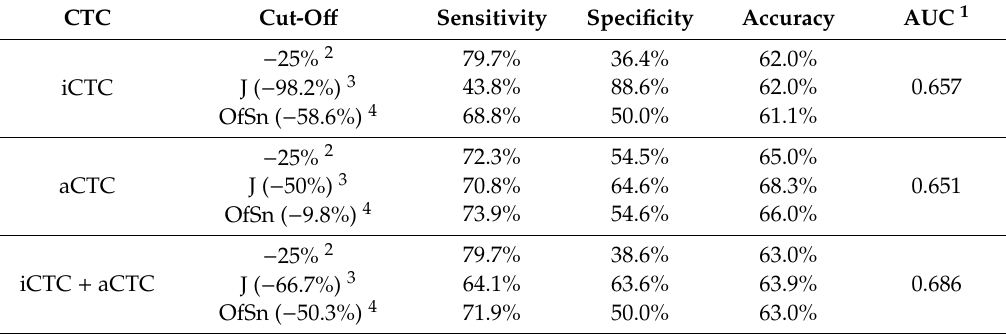
1 AUC: area under the curve; 2 − 25%: 25% reduction cut-o ff ; 3 J: Youden J point with the percent reduction corresponding to that J point represented in the parentheses; 4 OfSn: cut-o ff optimized for sensitivity with the corresponding percent reduction represented in the